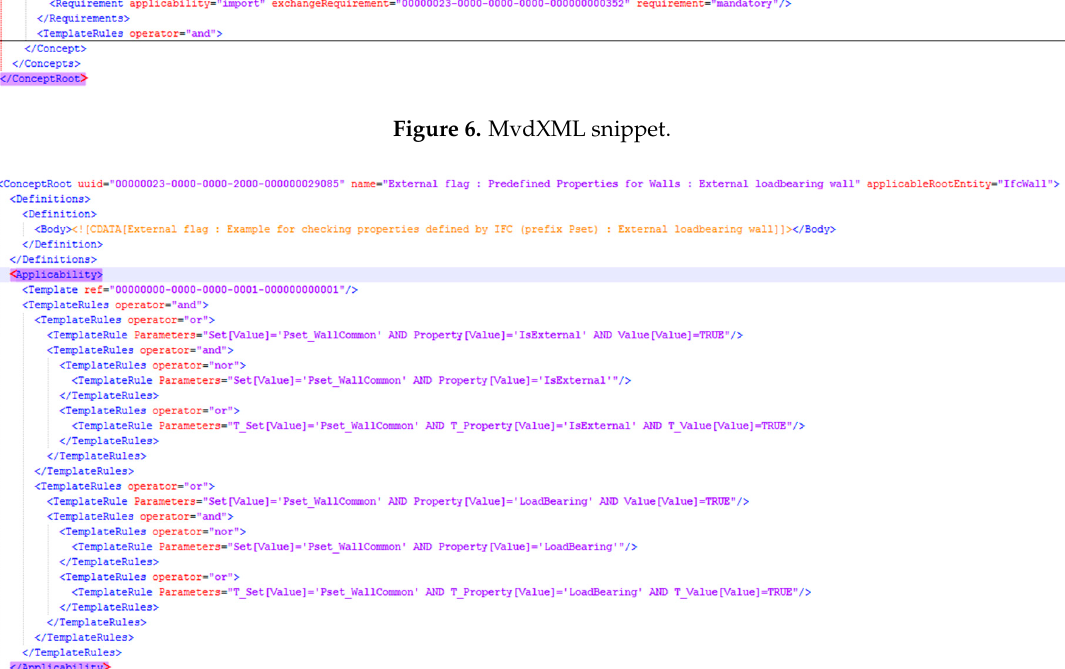
Table 2. Examples of requirements.